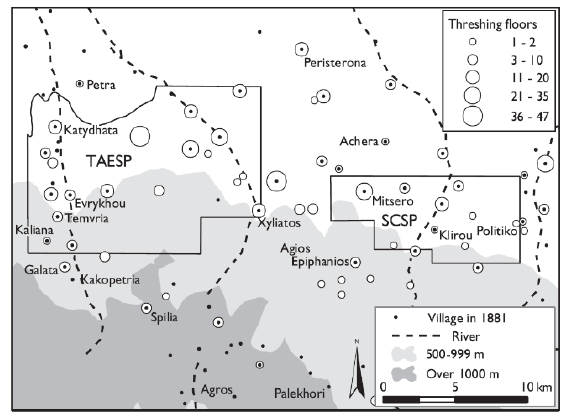
Figure 11. Northern Troodos mountains, Cyprus; villages recorded in the 1881 Census, and distribution of threshing floors (Given M.,